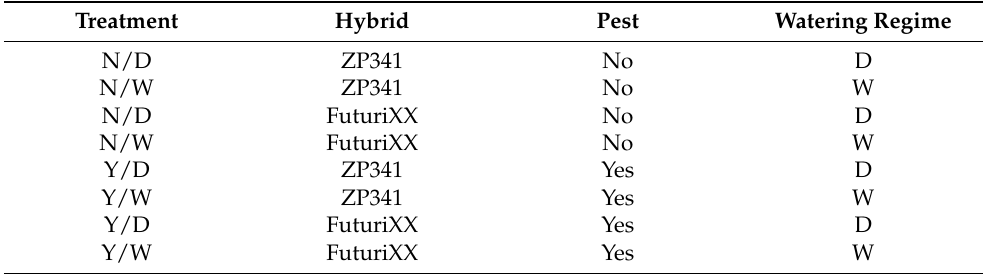
Table 1. Setup of factorial pot experiment, where two maize hybrids were subjected to two watering regimes (water-deficient [D] vs. well-watered [W]) and to belowground herbivory (no wireworms [N] vs. wireworm-infested